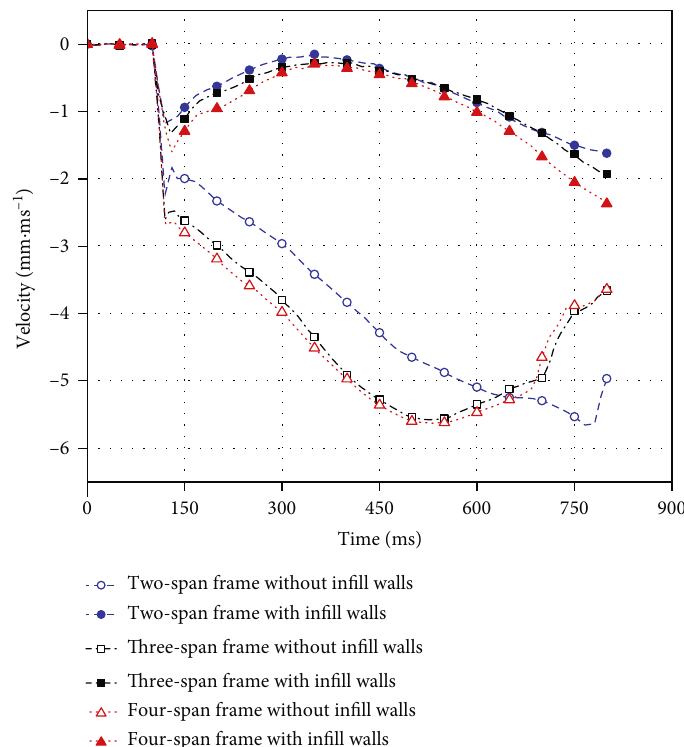
Figure 18: The z -direction velocity at the midpoint of the second fl oor side column.